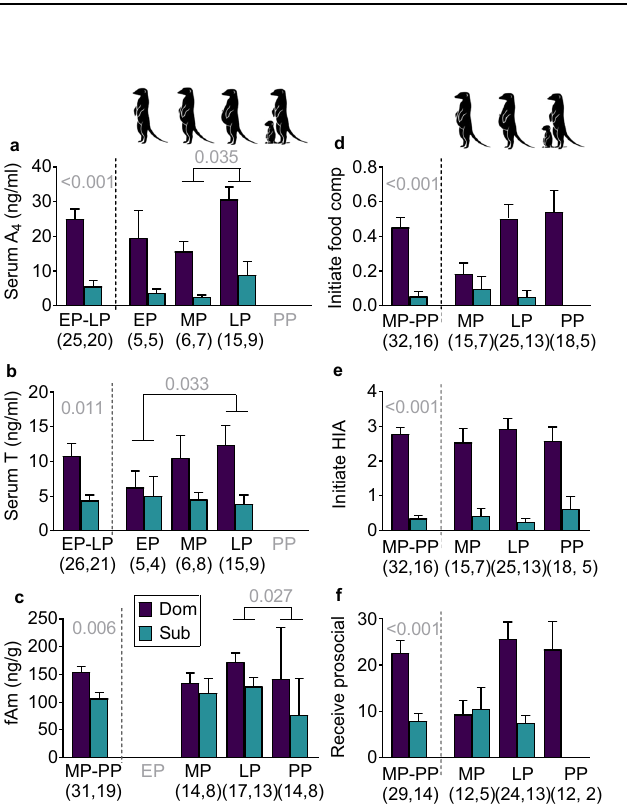
Fig. 1 Normative status differences in androgen concentrations and behavioural rates from early pregnancy to post-parturition in wild meerkats. Concentrations of a serum androstenedione (A 4 ), b serum testosterone (T) and c faecal androgen metabolites (fAm), as well as hourly rates of d initiating food competition, e initiating high-intensity aggression (HIA) and f receiving prosocial overtures vary in meerkat dams by status (dominant: purple; subordinate: teal) and by pregnancy stage (early, mid and late pregnancy, plus the fi rst two weeks postpartum: EP, MP, LP and PP, respectively). Vertical dashed lines separate mean + s.e. values overall from those by pregnancy stage. Analyses performed on 187 biological samples from 53 dams and 1174 focal observations during 48 pregnancies of 37 dams. GLMMs (or LMM in c ), with two-tailed χ 2 , showed greater endocrine and behavioural values in dominant than subordinate dams throughout; least signi fi cant differences (LSD) showed greatest endocrine values in LP (for dominant and subordinate dams combined); signi fi cant P values in grey. (Icons of pregnancy stages drawn by S. Bornbusch). See Supplementary Fig. 2 for the distribution of raw endocrine data. Source data are provided as a Source Data fi